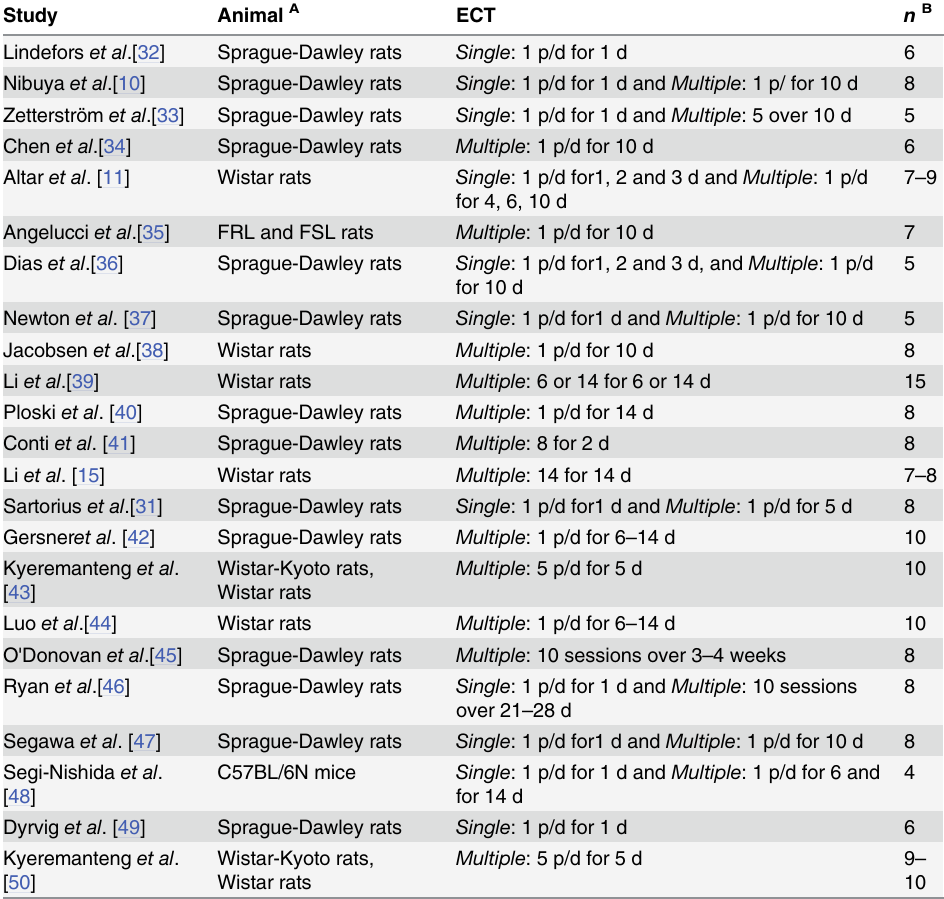
Table 1. Basic information on the preclinical studies included in the meta-analysis.